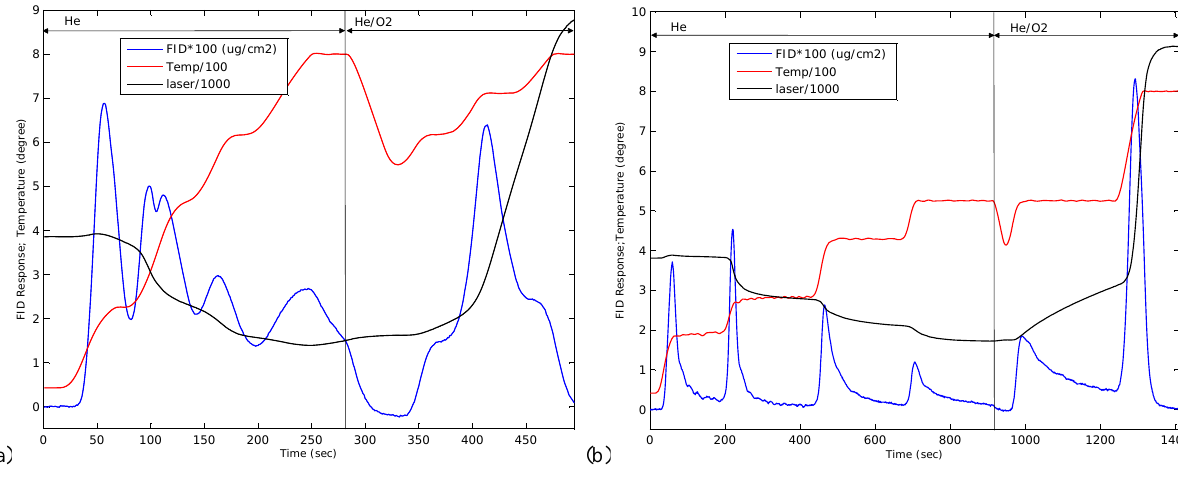
Fig. 1. Thermograms from the analysis of a typical ambient PM 2 . 5 sample collected in Ispra, with (a) a NIOSH-type and (b) a He-550